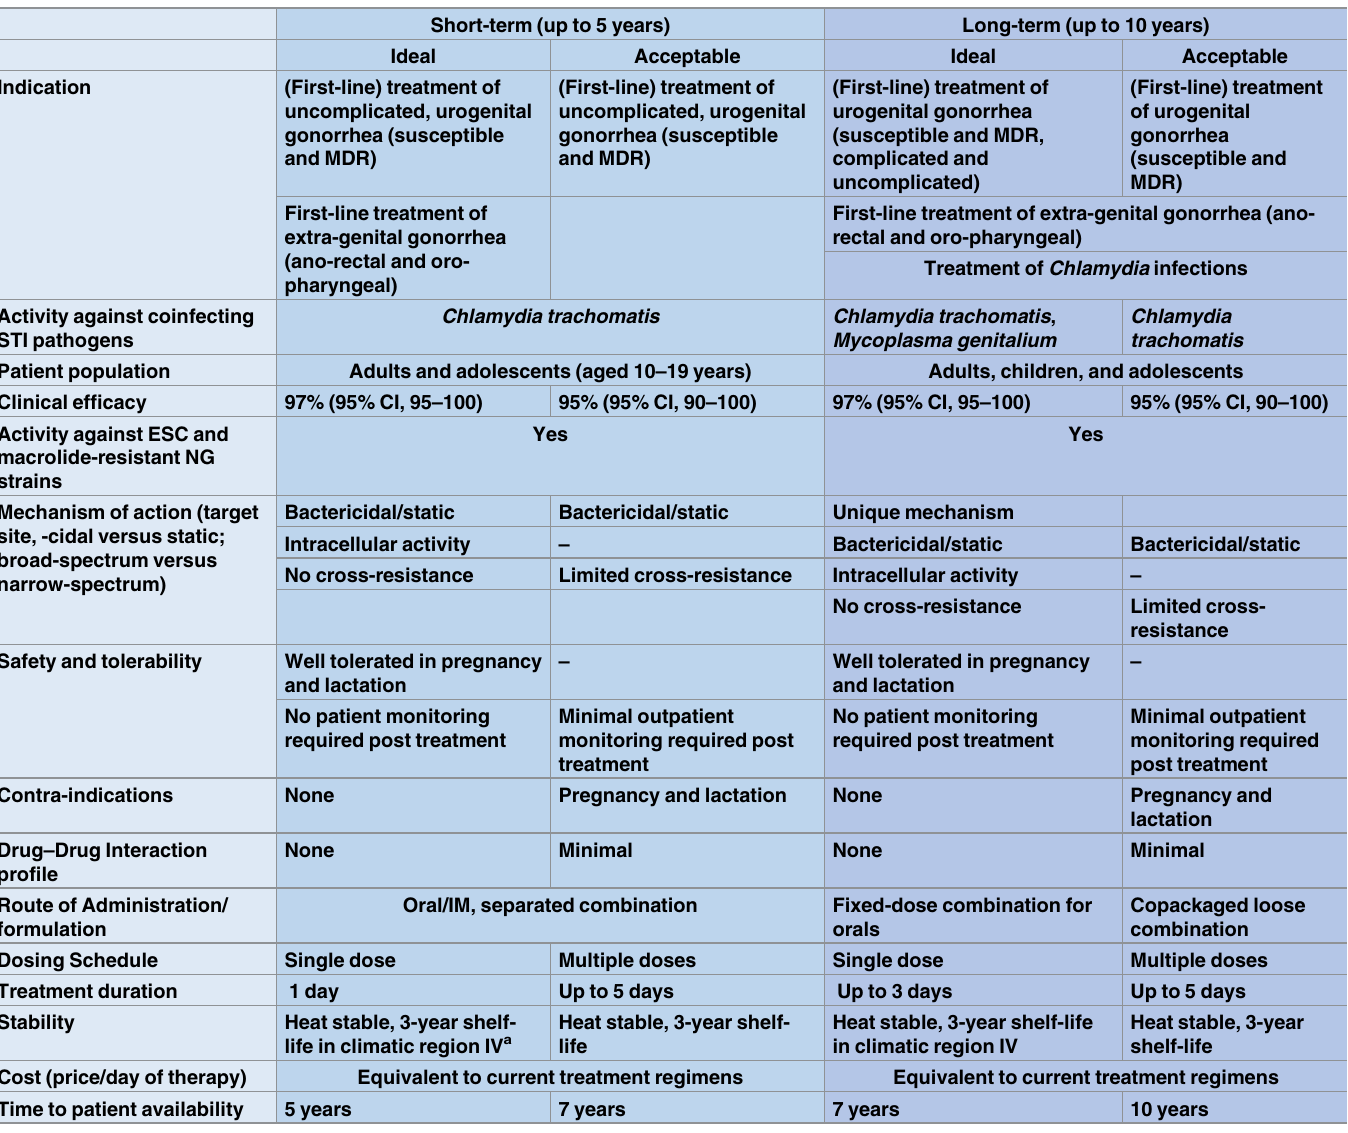
Table 1. Consensus Target Product Profile (TPP) developed by the gonorrhea expert